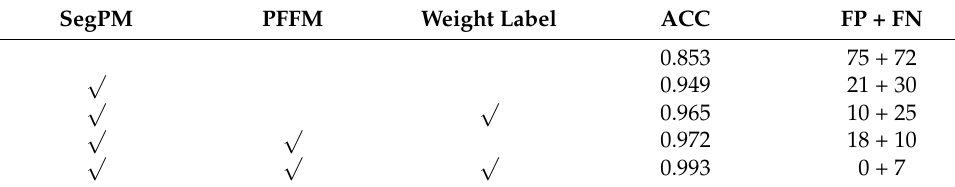
Table 5. Performance of every individual module on the bearing dataset.